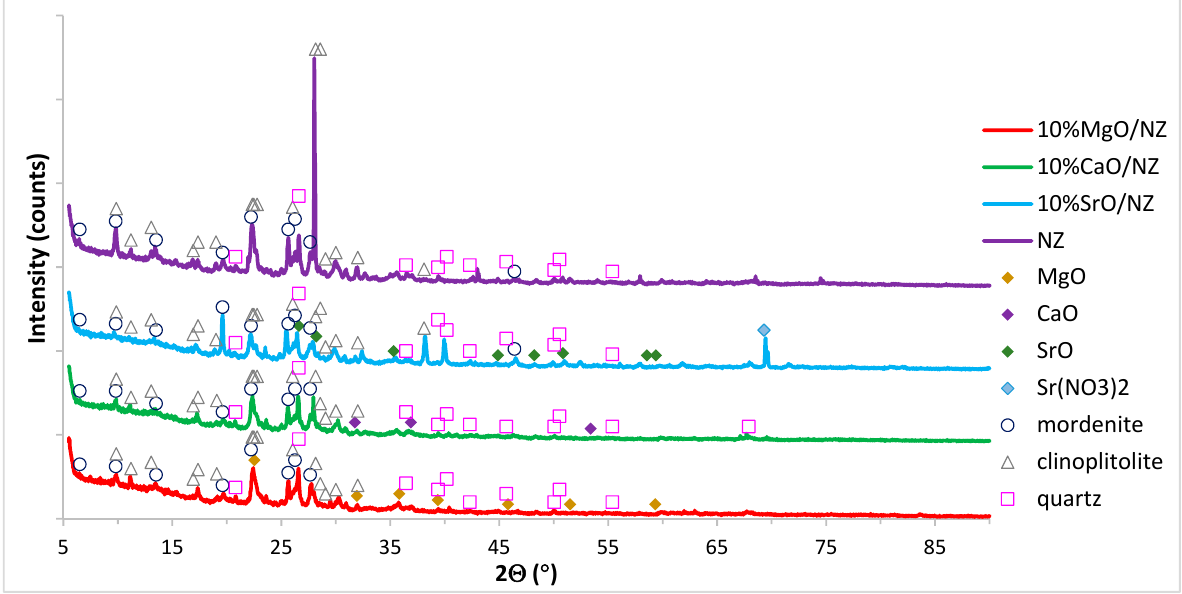
Figure 2. XRD analysis of the calcined in an air atmosphere at 400 °C for 4 h of metallic oxide catalysts supported on natural zeolite.